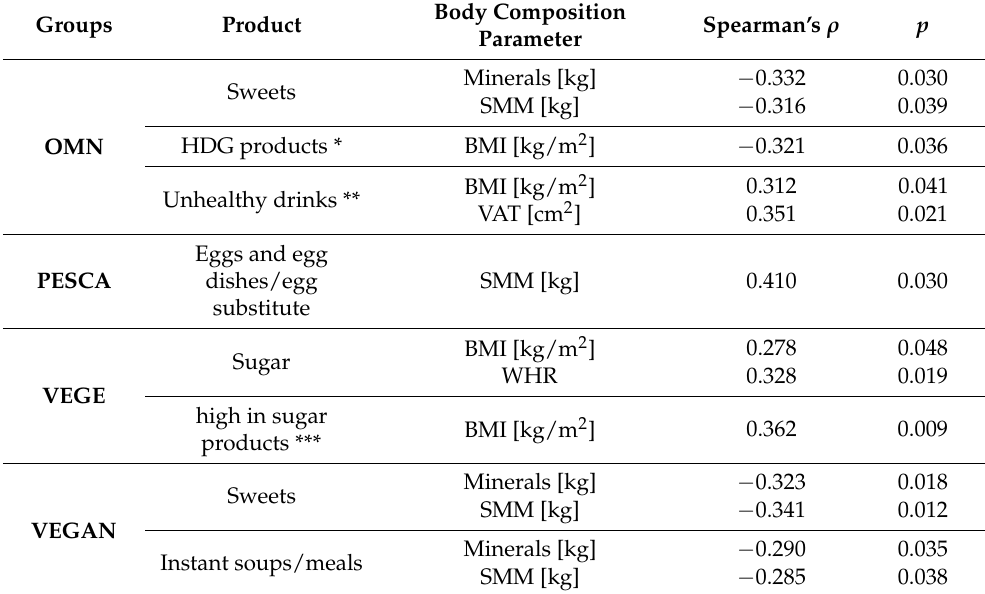
Table 8. Correlations between the body composition parameters and the product consumption frequency.